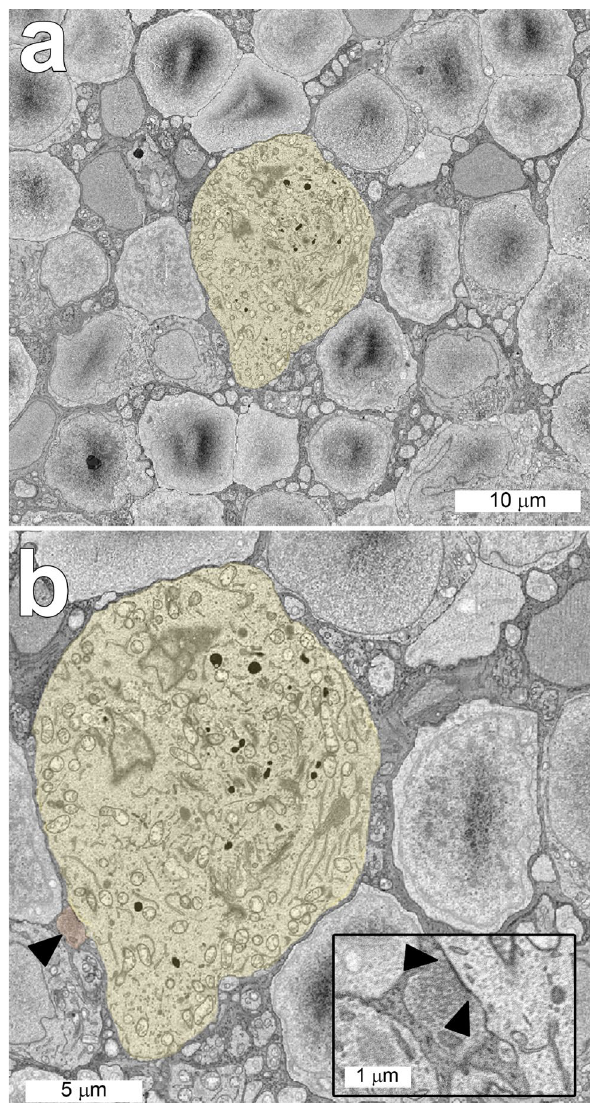
Figure 1. Horizontal sections through the inner nuclear layer of the nasal volume including the soma of displaced ipRGC 11345. ( a ). Note that the diameter of the ipRGC soma (yellow) was much larger than those of the surrounding cells. ( b ). There was a synapse ( ▲ ) from an amacrine cell onto the soma of this ipRGC. The boundaries of the synaptic density are indicated at higher magnification in the